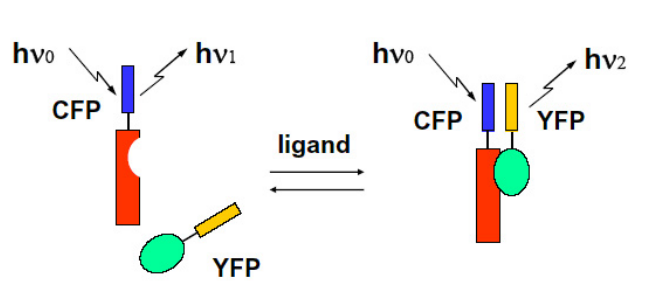
Figure 9. FRET phenomenon occurred between hetero-molecules.